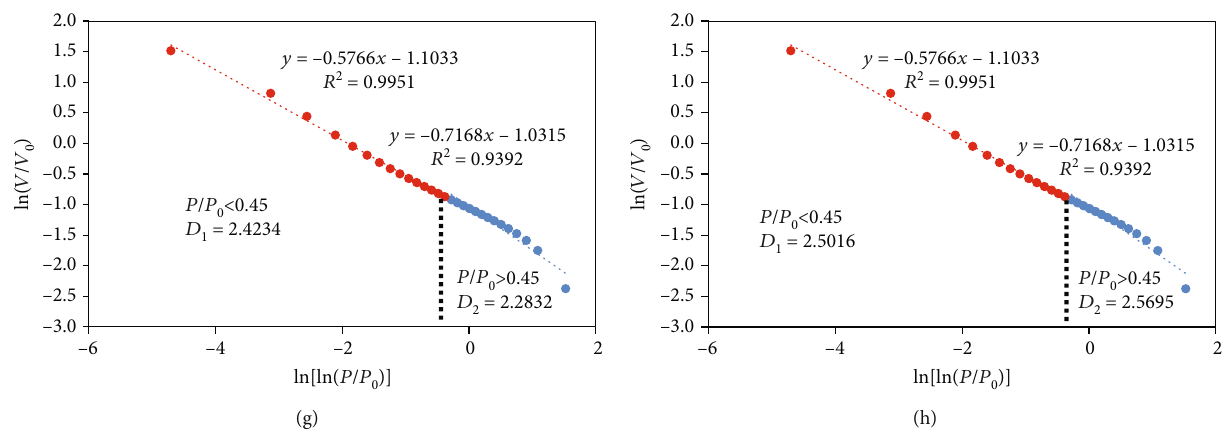
Figure 7: Pore fractal characteristics of the eight samples. (a) MSCSs-1. (b) MSCSs-2. (c) MSCSs-3. (d MSCSs-4. (e) MSCSs-5. (f) MSCSs-6. (g) MSCSs-7. (h) MSCSs-8. Table 3: Pore structure parameters of the eight samples measured by low pressure N 2